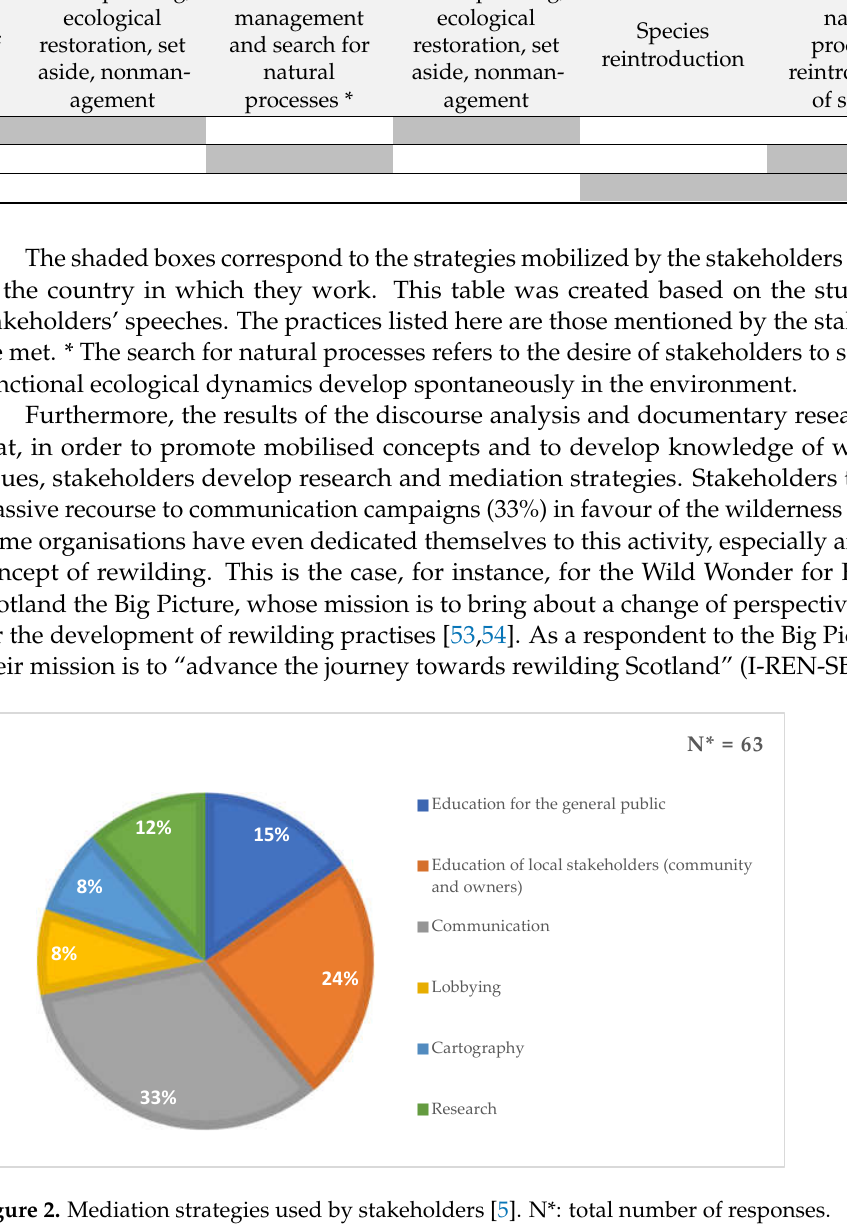
Table 4. Summary of concepts used according to the strategies mobilised and the country in which they are implemented [5].